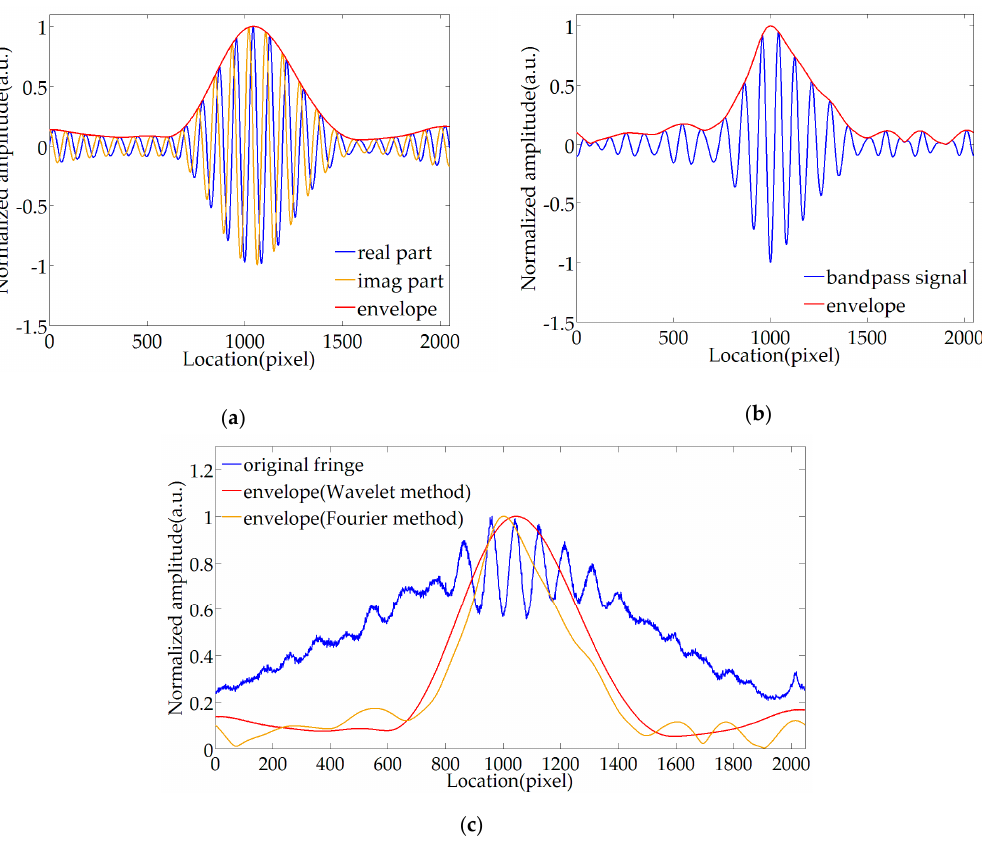
Figure 11. Comparison of envelope extraction methods: ( a ) wavelet normalized envelope extraction effect; ( b ) Fourier normalized envelope extraction effect; ( c ) comparison between envelope curve and original fringe.